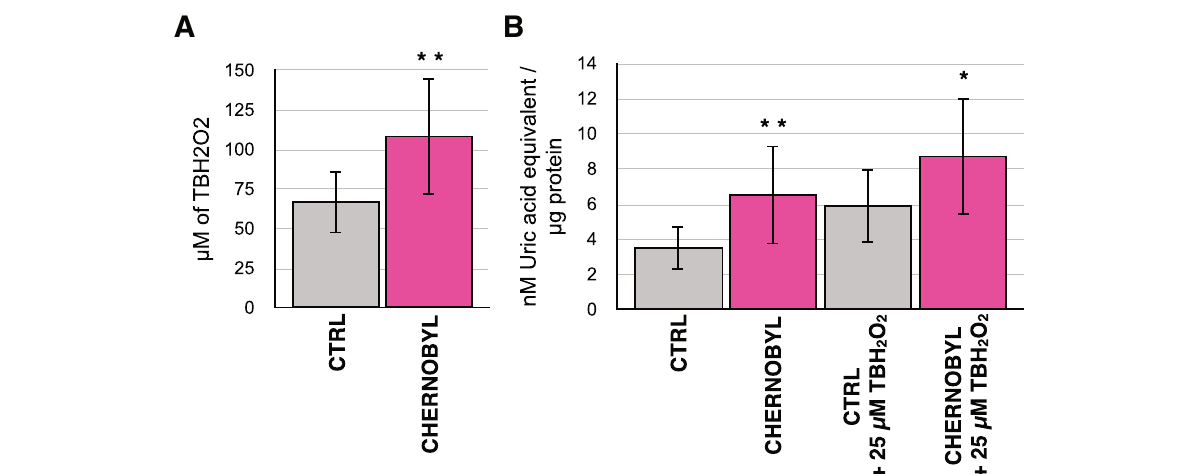
Fig. 2 Chernobyl fibroblasts survive in higher oxidant concentration and have more antioxidants than control fibroblasts. a Fibroblasts isolated from Chernobyl bank voles were, on average, able to grow in about 40 μ M higher concentration of oxidizing agent tert-butyl hydroperoxide (TBH2O2) than control bank vole fibroblasts. Cells were treated with different concentrations of the oxidant for 24 h after which fresh cell culture media was changed and cells were let grow for 7 days before scoring the wells that remained 100% confluent. b . Chernobyl fibroblasts have significantly higher total antioxidant capacity in untreated and oxidant-treated cells than control fibroblasts. For oxidant treatment cells were grown in 25 μ M of TBH2O2 for 24 h before the total antioxidant capacity was measured. Results are from three separate experiments using eight Chernobyl ( N = 24) and eight control ( N = 24) cell lines, variation is shown by standard deviation, and statistical analysis was done with Student ’ s t-test (* = p ≤ 0.05, ** = p ≤